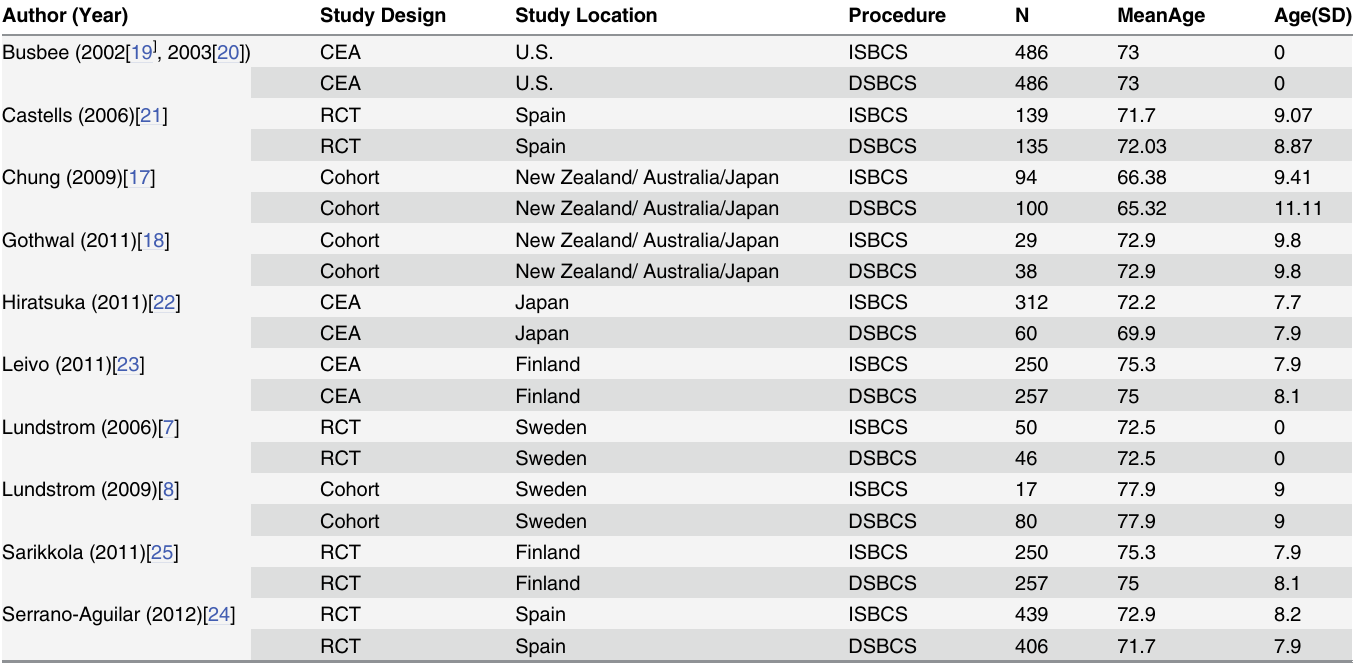
Table 1. Charaterisctics of Studies Included in